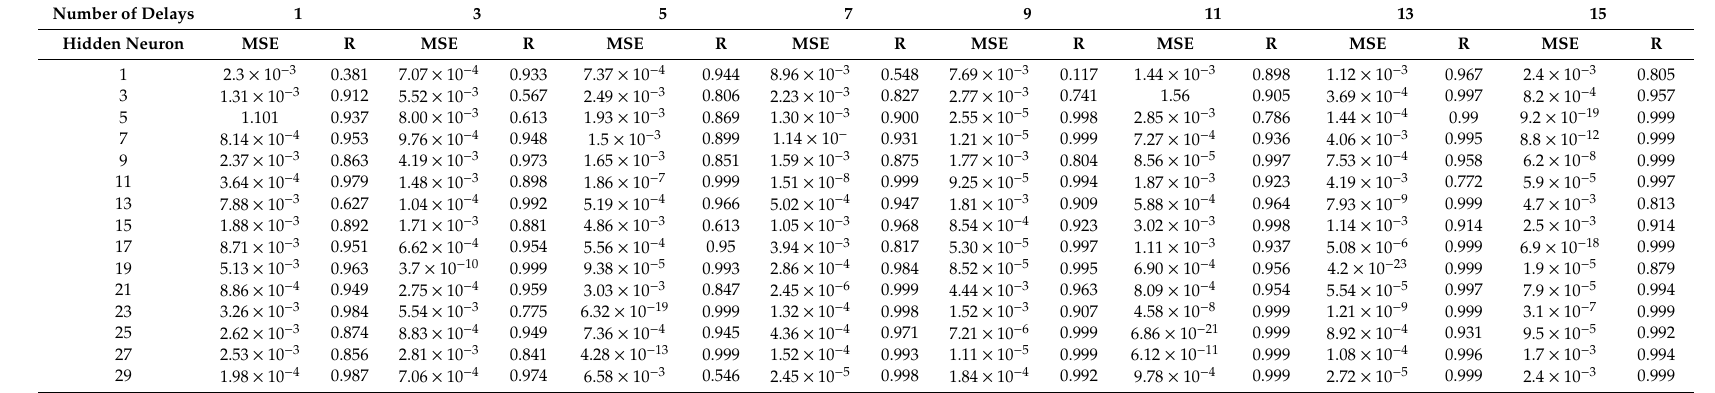
Table A2. Detail results of the optimization of the hidden neurons at varying delay using training data for